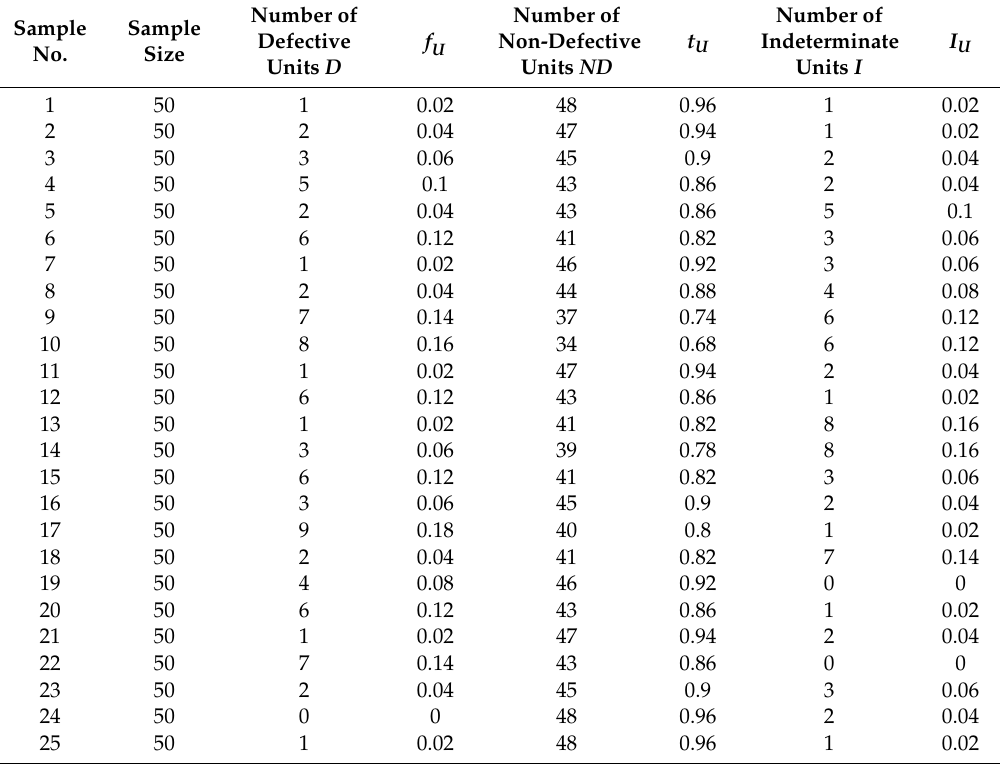
Table 2. Neutrosophic data when n =